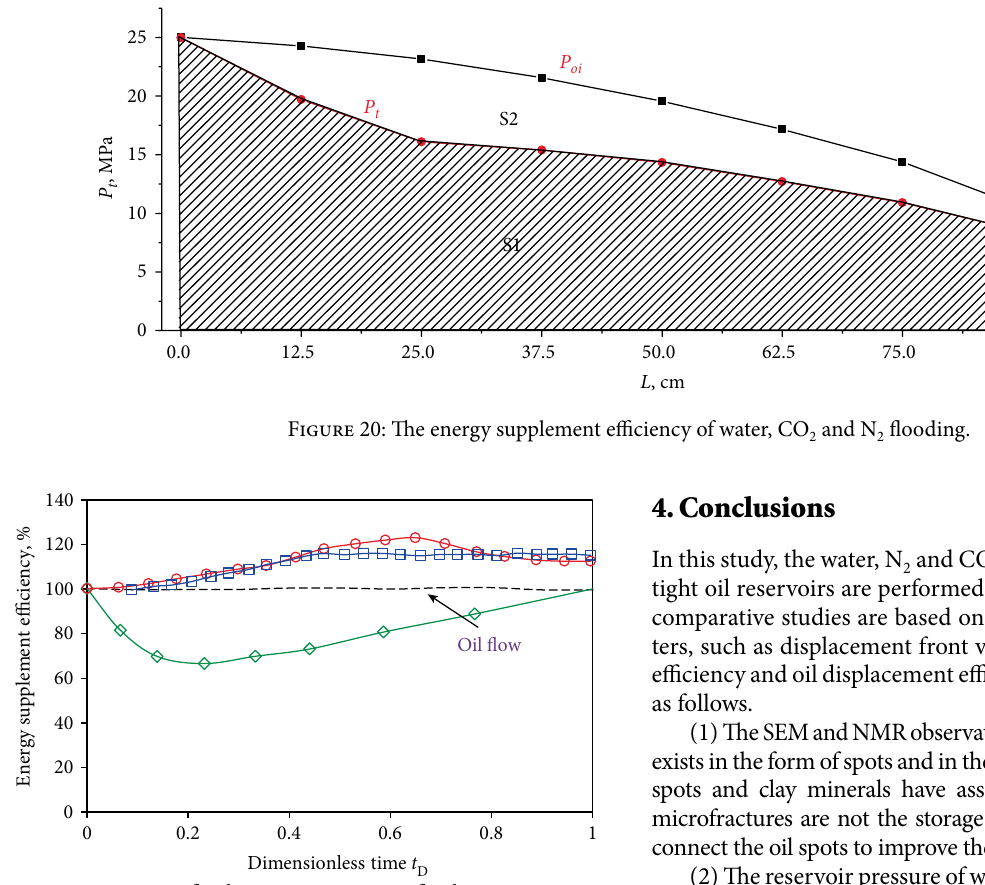
Figure 21: The energy supplement efficiency of water, CO flooding.